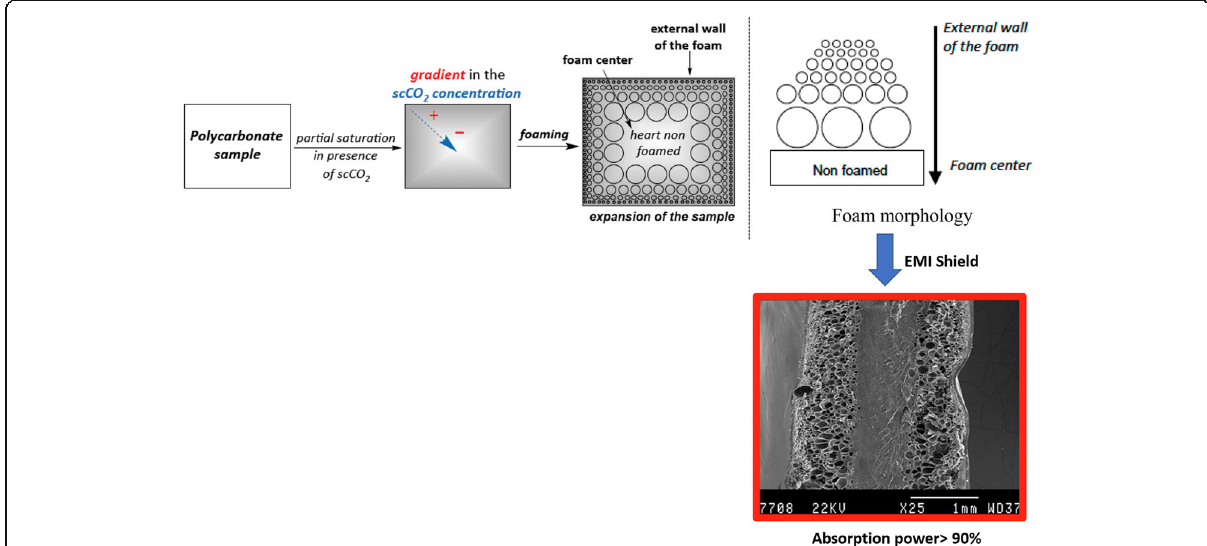
Fig. 21 Schematic of gradient foaming process and scanning electron micrograph of the EMI shield obtained with absorption power>90%. Adapted with permission from Detrembleur et al. [107], copyright 2015